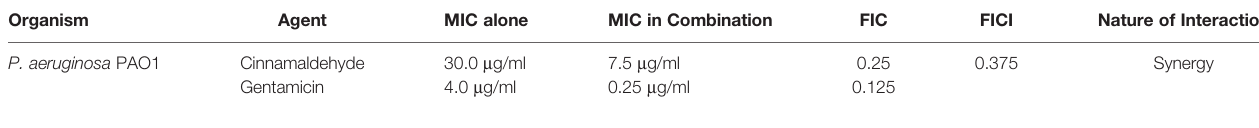
TABLE 1 | Fractional inhibitory concentration (FIC) and FIC index for testing synergy between CiNN and GeN against P. aeruginosa PAO1.